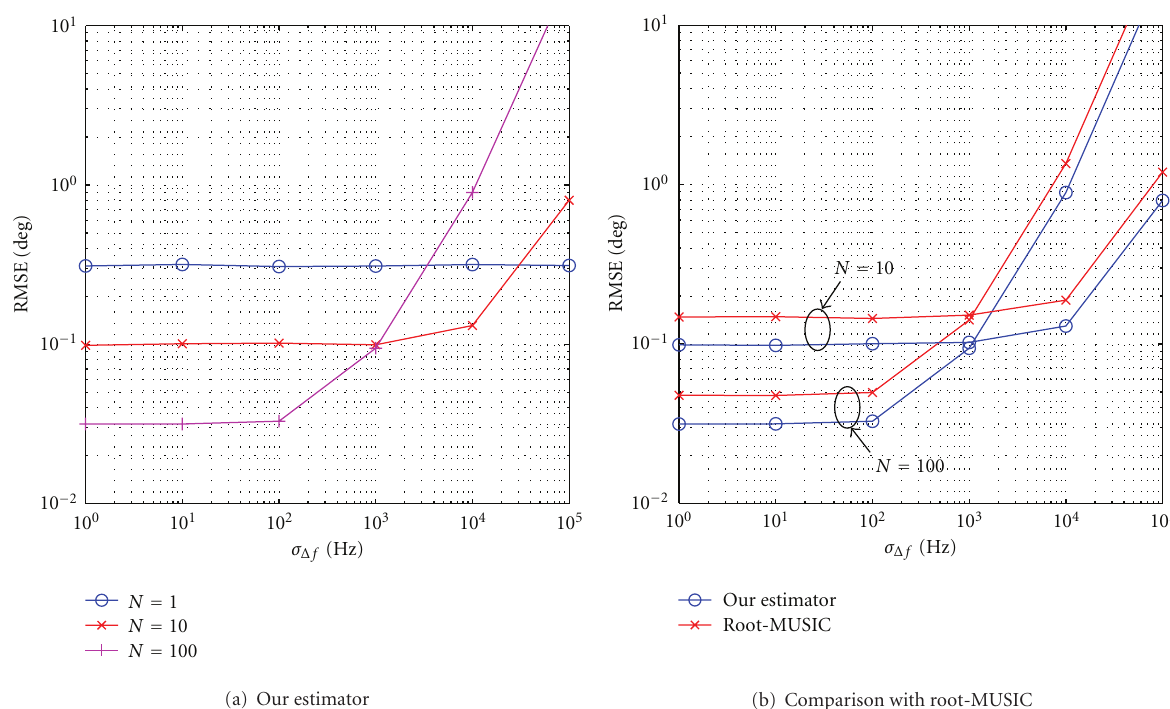
Figure 8: Aggregate RMSE as a function of σ Δ f and N